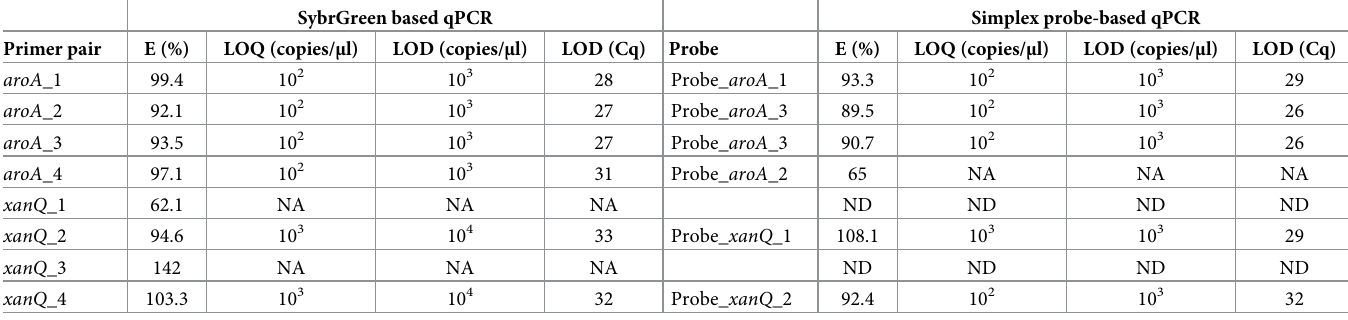
Table 3. Comparison of efficiency and limit of quantification in different PCR assays for all primer pairs. For each primer pair (Table 1) the efficiency, limit of quan- tification (LOQ) and limit of detection (LOD) were assessed using a 10-fold dilution series of a standard fragment (10 8 − 10 0 copies/ μ l).